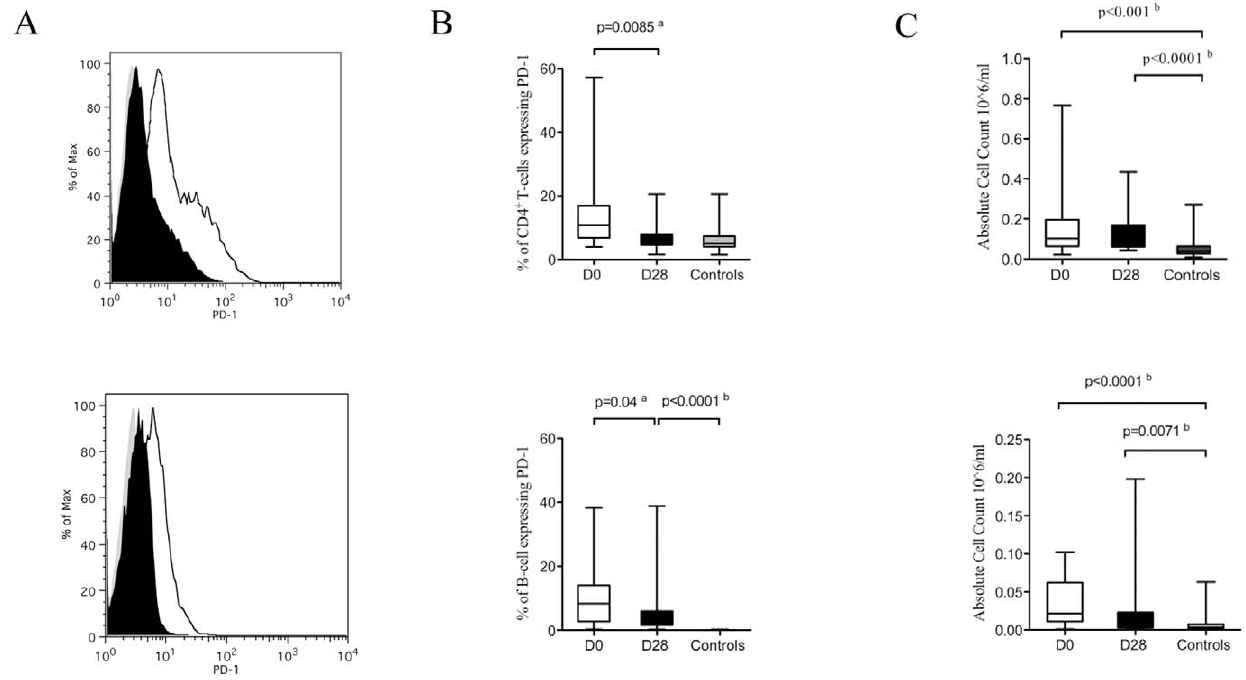
Figure 3. PD-1 expression is up-regulated on CD4 and CD19 positive cells during acute P.falciparum infection in children. A. Flow cytometry plots demonstrating increased expression of PD-1 on CD4 + T-cells (top row) and CD19 positive cells (bottom row) on Day 0 (black) compared to Day 28 (white). B. The percentage of programmed death-1 (PD-1) expressing, CD4 and CD19 positive cells in acute uncomplicated P. falciparum malaria infection (white box), on convalescence in the same donors (black box) and in age- and sex- matched healthy controls (grey box). C. The absolute number of programmed death-1 (PD-1) expressing, CD4 and CD19 positive cells in acute uncomplicated P. falciparum malaria infection (white box), on convalescence in the same donors (black box) and in age- and sex- matched healthy controls (grey box). All gates were set using appropriate isotype controls. a P values calculated using Wilcoxon rank comparison of matched pairs. b p values calculated using Mann-Whitney U statistical comparison of unmatched pairs.